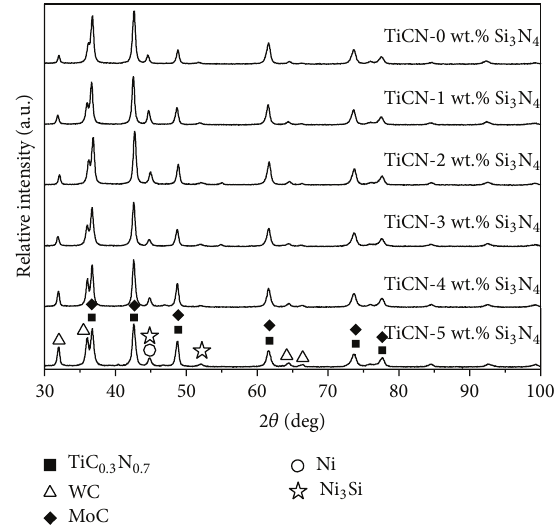
Figure 1: Typical XRD patterns of the as-prepared TiCN-based cermets with different amounts of Si 3 N 4 nanopowder.